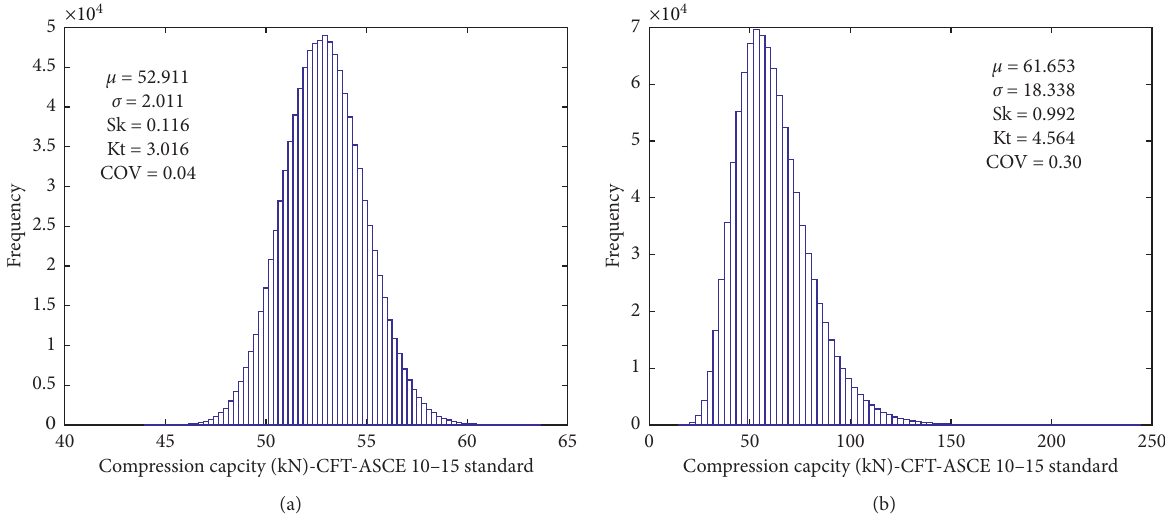
Figure 9: Compression capacity histograms for ASCE 10-15 Standard: (a) compression capacity without ME; (b) compression capacity with ME. CFT—Column flexure-torsion buckling mode, μ —Mean, σ —Std. deviation, Sk—Skewness, Kt—Kurtosis, and COV—Coefficient of